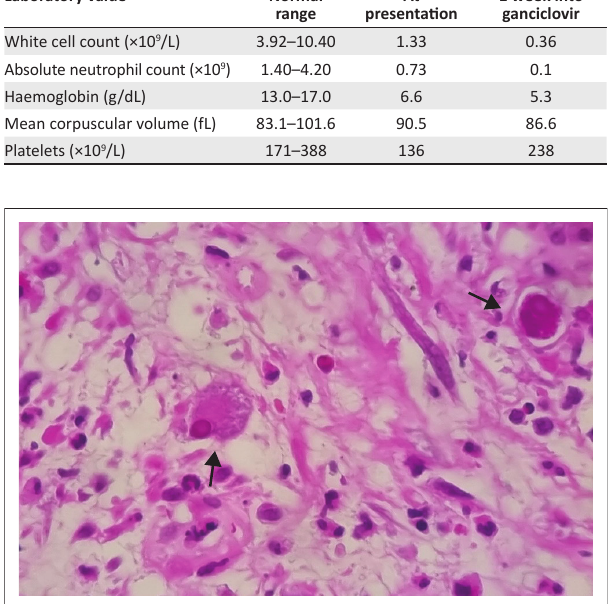
FIGURE 1: Haematoxylin and eosin (H&E) stain of the oesophageal lesion (at × 40 magnification) demonstrating cytomegalovirus infected cells with intra-nuclear cytomegalovirus inclusions (black arrows).